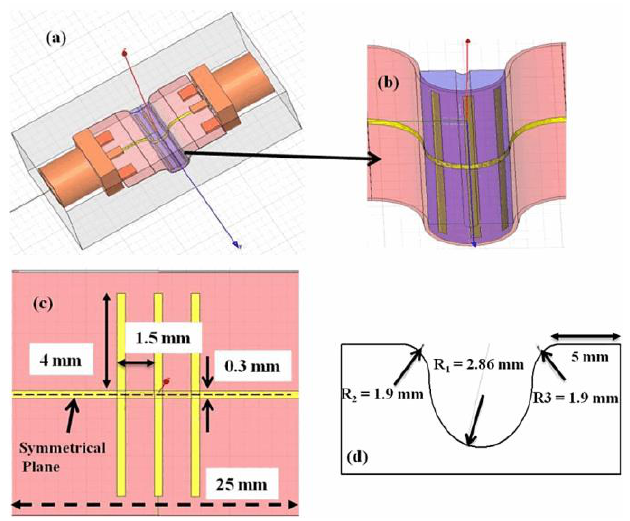
Figure 13. ( a ) Design and dimensions of the proposed sensor filled with aqueous chemicals; ( b ) zoomed structure of the bent portion highlighted in ( a ); ( c ) top view of the structure showing the dimensions; and ( d ) measurements of 3D-printed Acrylonitrile Butadiene Styrene (ABS) plastic module [68].